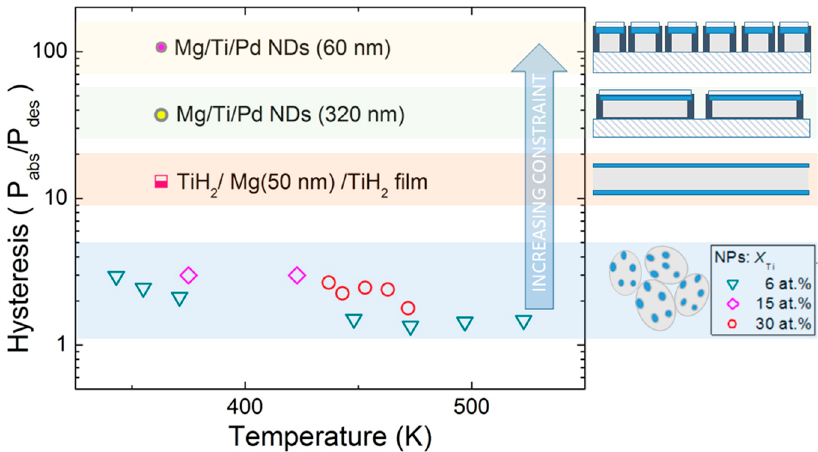
Figure 6. Hysteresis value p abs / p des vs. temperature for a collection of Mg–Ti–H NPs with varying Ti content ( X Ti = 6, 15, 30 atom %) [8], confronted with hysteresis value for NDs of different diameter (60 nm and 320 nm) [5] and for a quasi-free 50 nm thick Mg film [7].